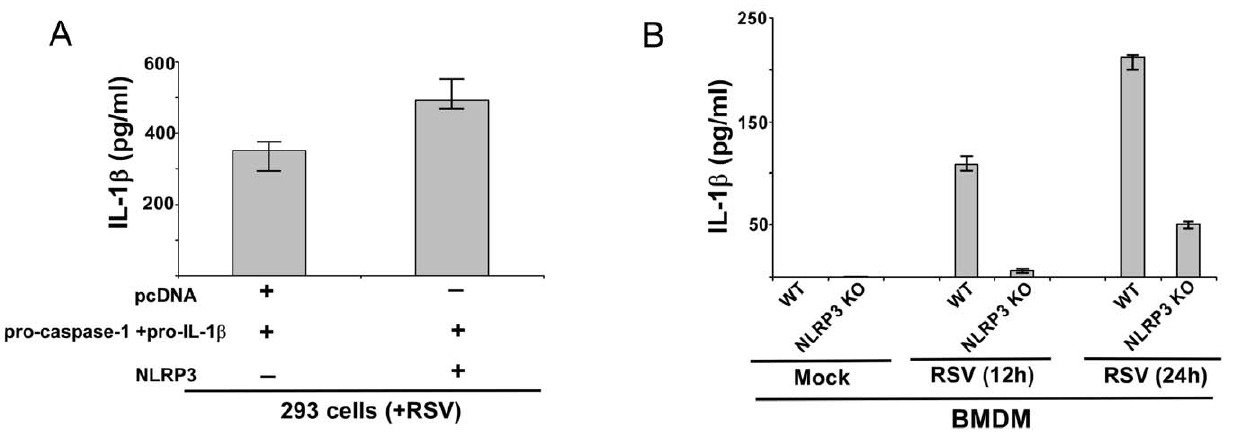
Figure 2. IL-1 b secretion during RSV infection requires NLRP3 expression. ( A ) 293 cells were transfected either with pcDNA (control), pro-IL- 1 b + pro-caspase-1 plasmids and NLRP3 plasmid. At 24 h post-transfection, cells were infected with RSV (1 MOI). At 12 h post-infection, medium supernatant was assessed for IL-1 b protein by ELISA analysis. ( B ) Wild type (WT) or NLRP3 knock-out (KO) BMDMs were infected with RSV (1 MOI). IL- 1 b levels in the medium supernatant were assayed by ELISA at 12 h and 24 h post-infection. Each value represents the mean 6 standard deviation from three independent experiments.